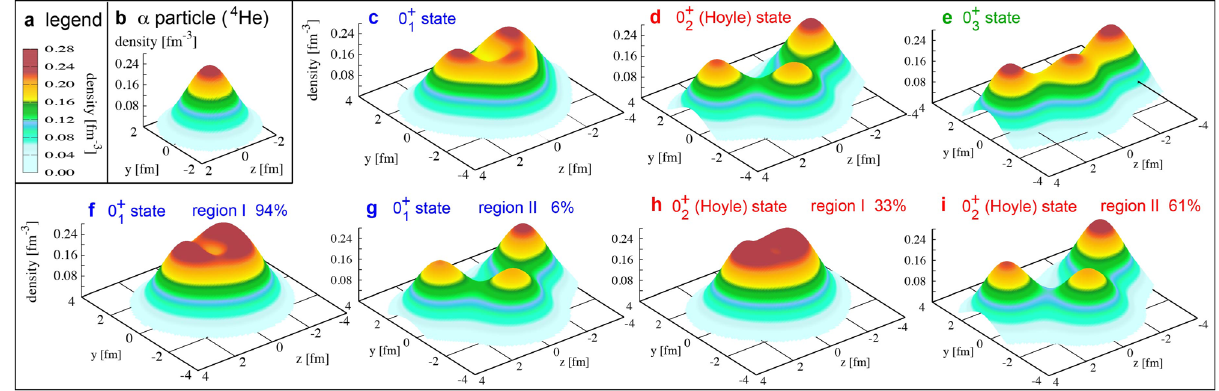
Fig. 6 Density pro fi les on the yz plane of α or 12 C nuclei. a Color code of the density. b Density of the α -particle ground state. c – e Density of 0 + states of 12 C nucleus. f – i Decomposition into the regions. The probability in the indicated region is